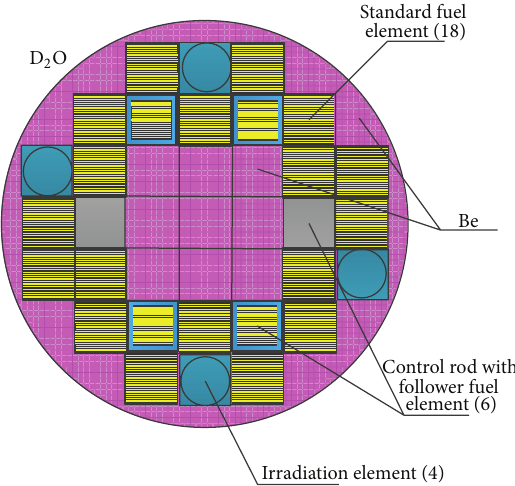
Figure 2: Modelling of the new core